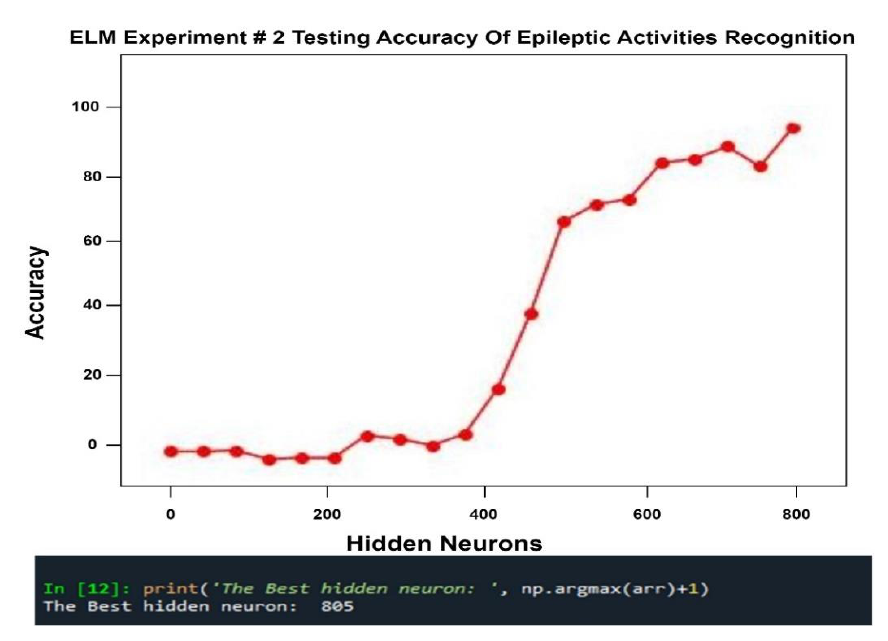
Figure 6. ELM Model Accuracy of Experiment #2.